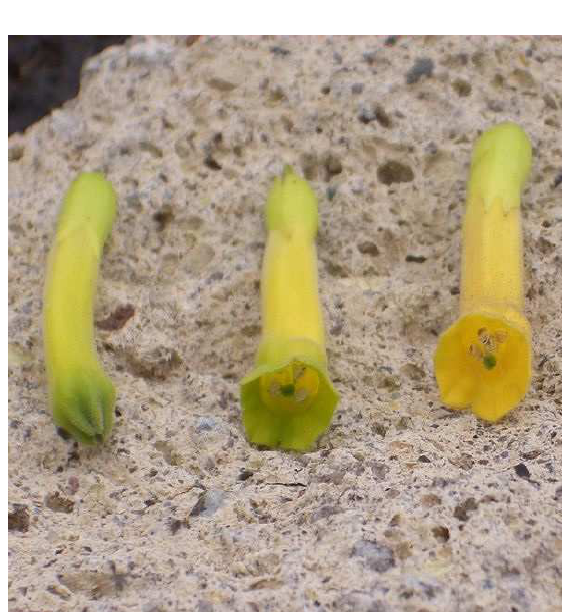
F IGURE 1: Stages of flower development in Nicotiana glauca . From left to right: closed late stage bud; newly opened flower; older flower showing colour change of mouth of corolla tube from green to yellow. Photograph by Jeff Ollerton in an invasive population on